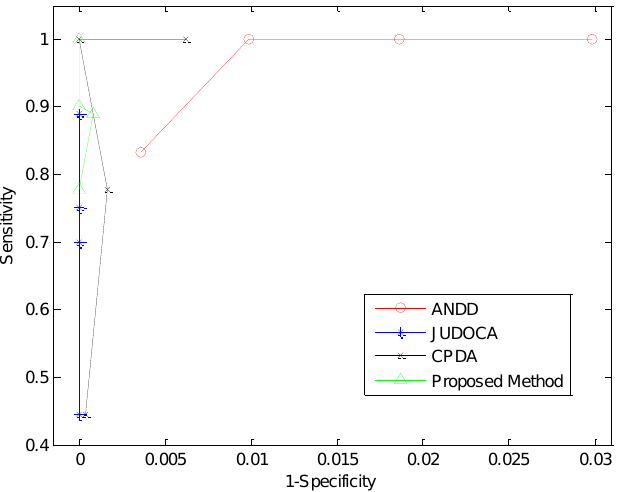
Figure 8. ROC plot comparison of the proposed method, ANDD, JUDOCA, and